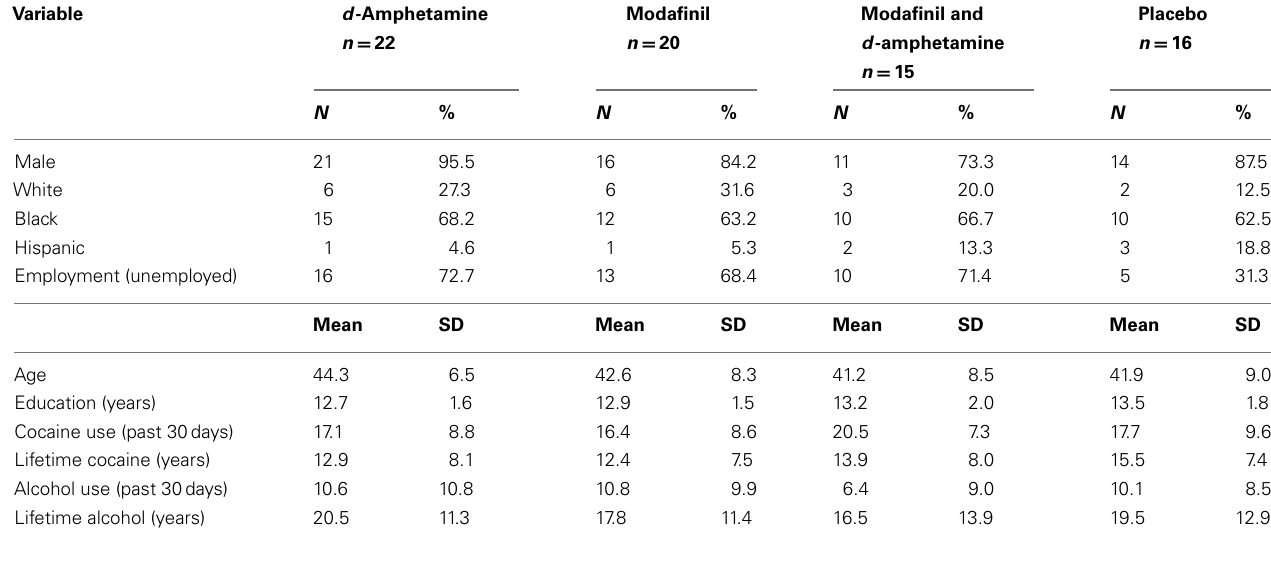
Table 1 | Demographic and drug use characteristics of participants at baseline by randomization status.